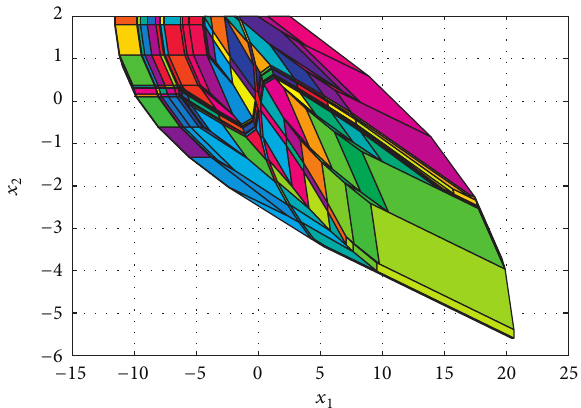
Figure 9: The partitions of feasible set X 3 5 ( 𝑁 = 5 ).